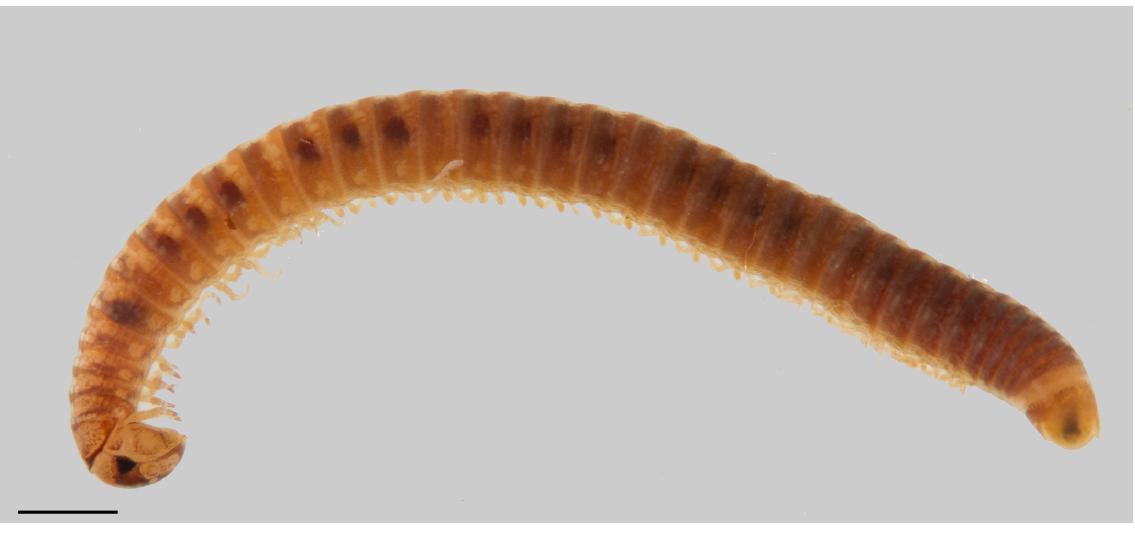
Fig. 1. Koiulus interruptus gen. et sp. nov., paratype, juvenile male from upper course of river Ko. Notice interrupted series of defense glands. Scale bar: 1